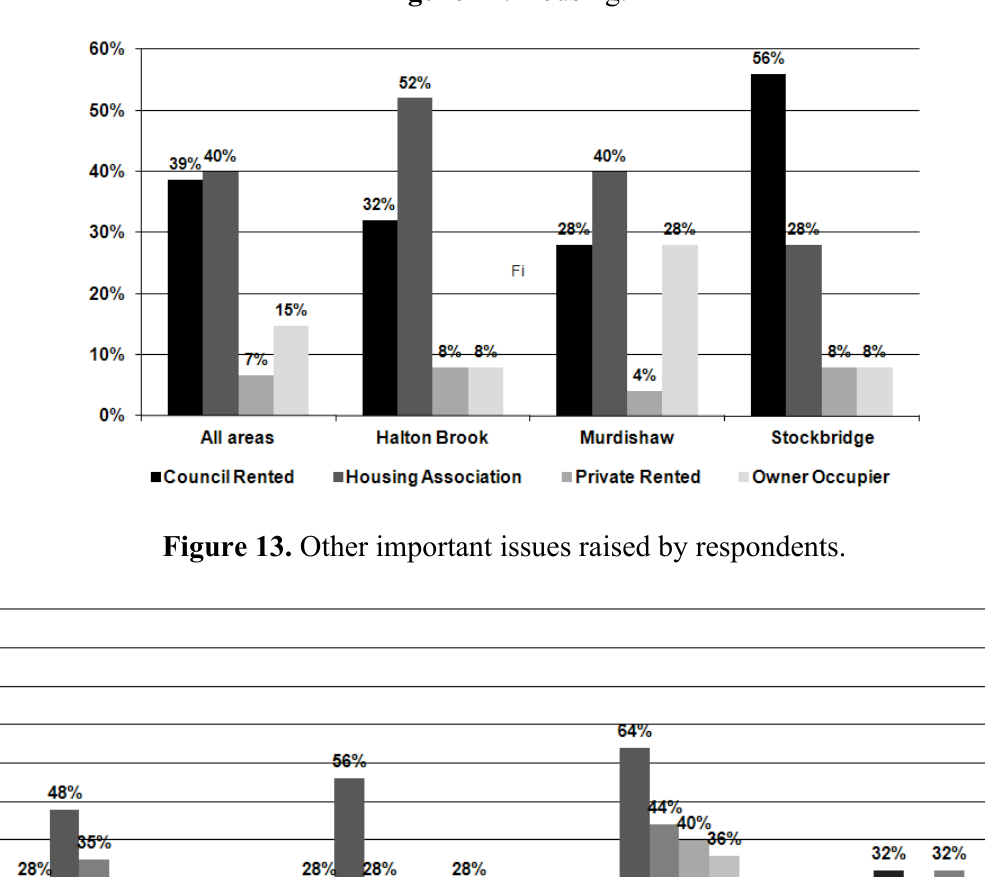
Figure 12. Housing.